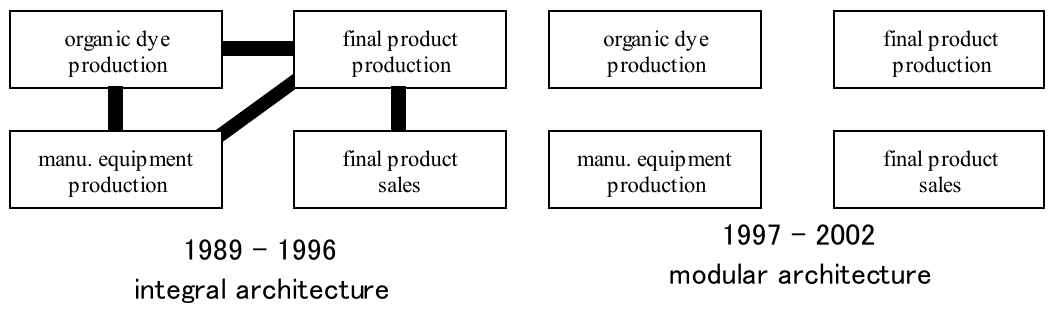
Figure 8. Business architecture went modular in the late